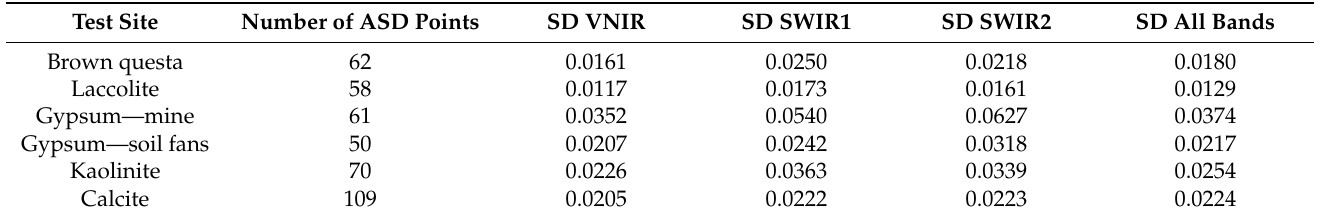
Table 3. Homogenous evaluation of each test site for ASD field measurments (SD for each point